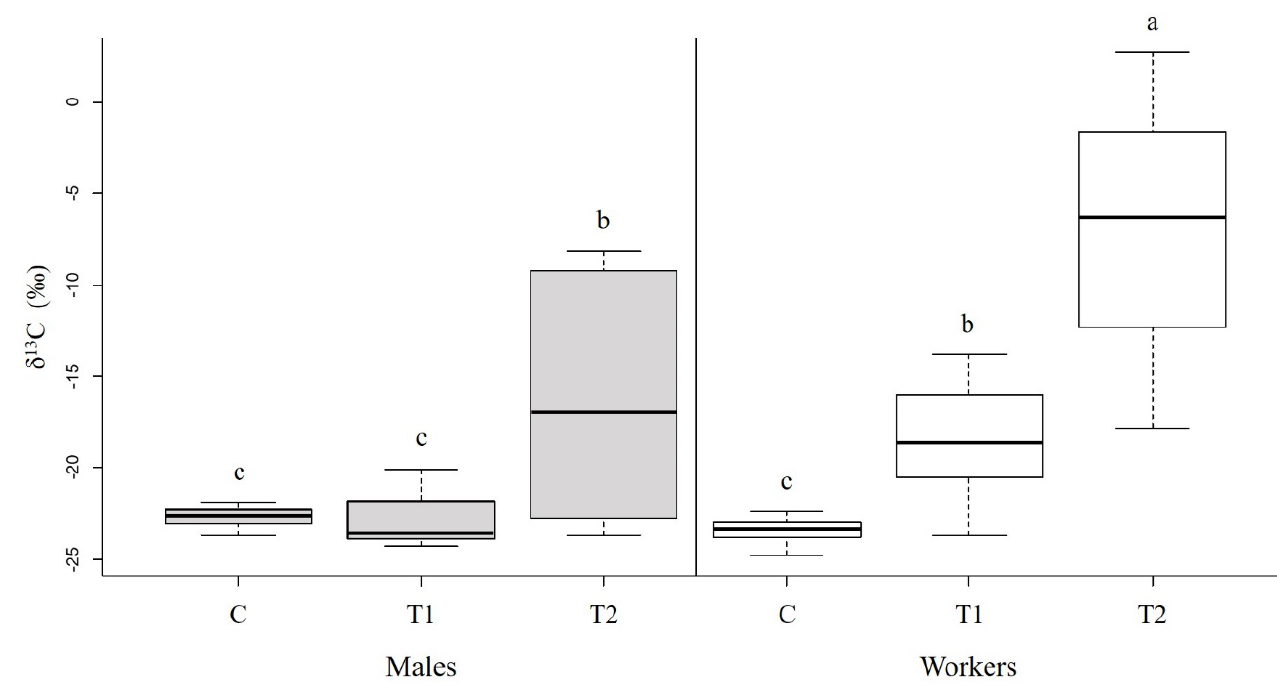
Figure 3. Incorporation of 13 C 1 -leucine from dietary proteins in the flight muscles of males and workers. δ 13 C values (‰, median + quartiles) in muscle tissues of males ( N = 34; left ; gray) and workers ( N = 35; right ; white) following ten days on a 13 C enriched protein diet in the absence (T1) or presence (T2) of larvae. Hornets fed on unlabeled protein (with and without larvae) served as controls (C). Higher delta values indicate higher 13 C levels. Different letters above bars indicate significant differences between diets and castes ( p < 0.05), according to Tukey post hoc pairwise comparisons. For the δ 13 C measurements, see Table S1.